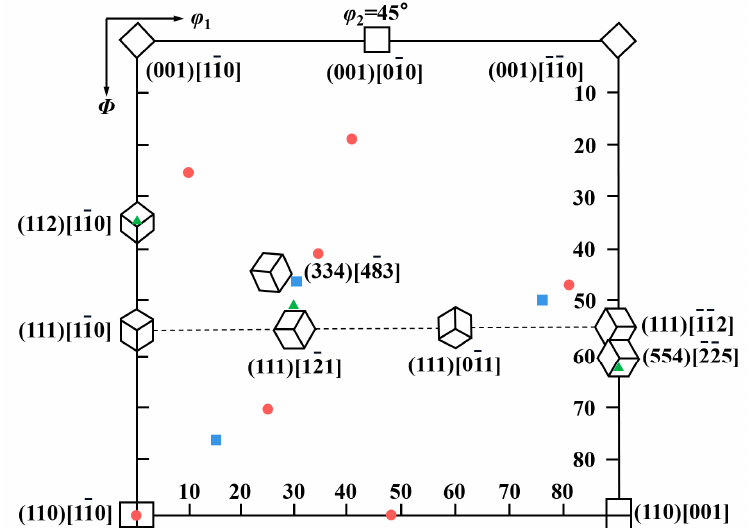
Figure 9. Constant ϕ 2 = 45 ◦ ODF section of bcc crystal and the texture of E36 ( • ), EH36 ( (cid:78) ) and Figure 9. Constant φ 2 = 45° ODF section of bcc crystal and the texture of E36 ( ● ), EH36 ( ▲ ) and FH36 ( (cid:4) ) steel plates. FH36 ( ■ ) steel plates. Table 4. Main texture components in the three grades of steel